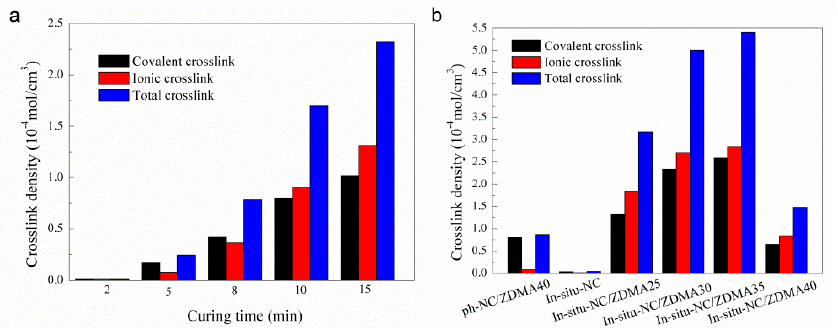
Figure 5. Crosslinking density of ( a ) in-situ-NC/ZDMA40 under different curing times, ( b ) Crosslinking density of in-situ-NC, in-situ-NC/ZDMAs, and ph-NC/ZDMA40.